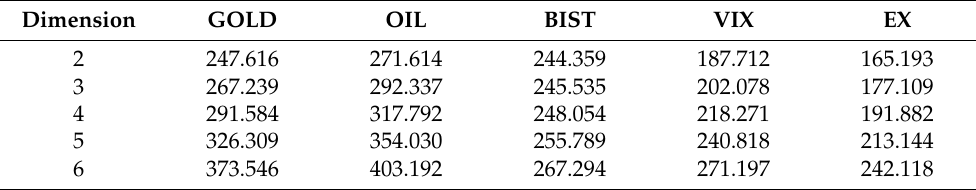
Table 2. BDS test results.